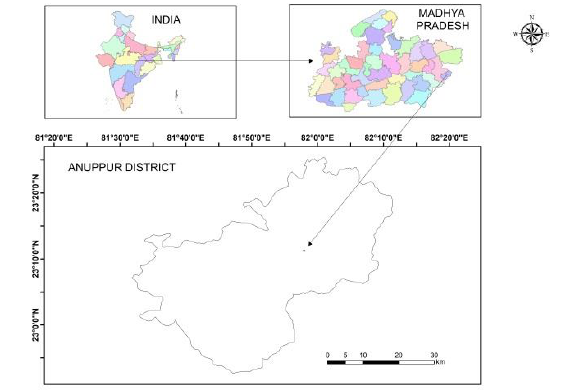
Fig 1: Location map of the study